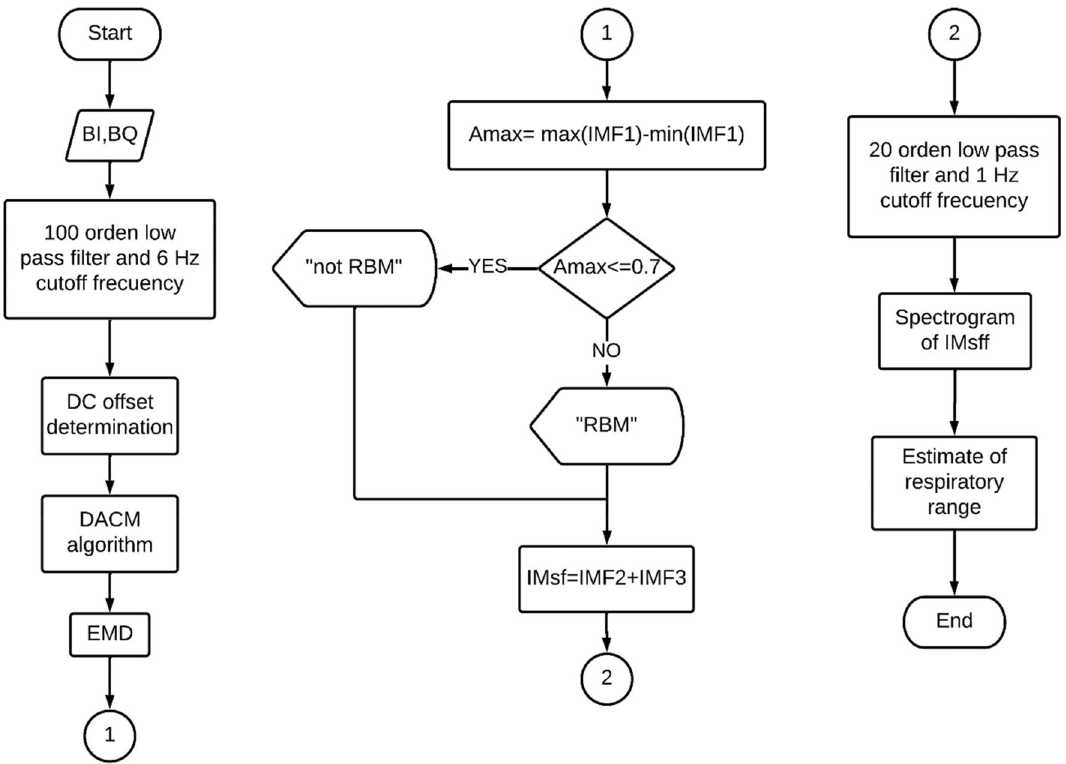
Figure 2. Flowchart of the proposed methodologies for RBM detection and for mitigating their harmful effects on the measurement of breathing